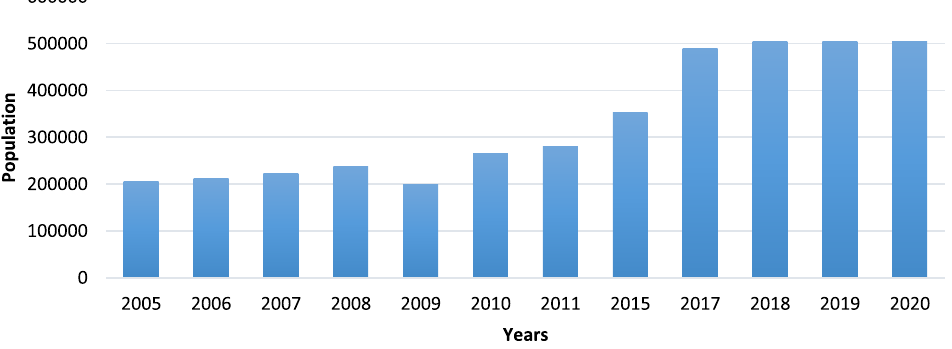
Fig. 1. Ajman Population from 2005 to 2020 [8].